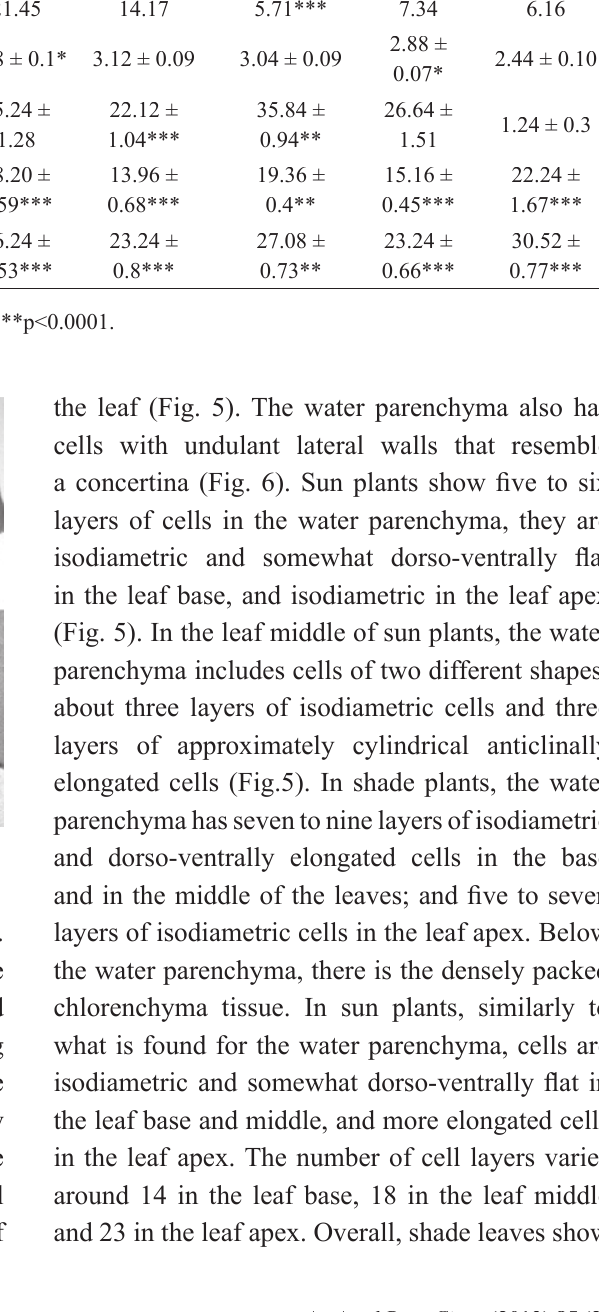
565 SUN AND SHADE ACCLIMATION IN Neoregelia cruenta